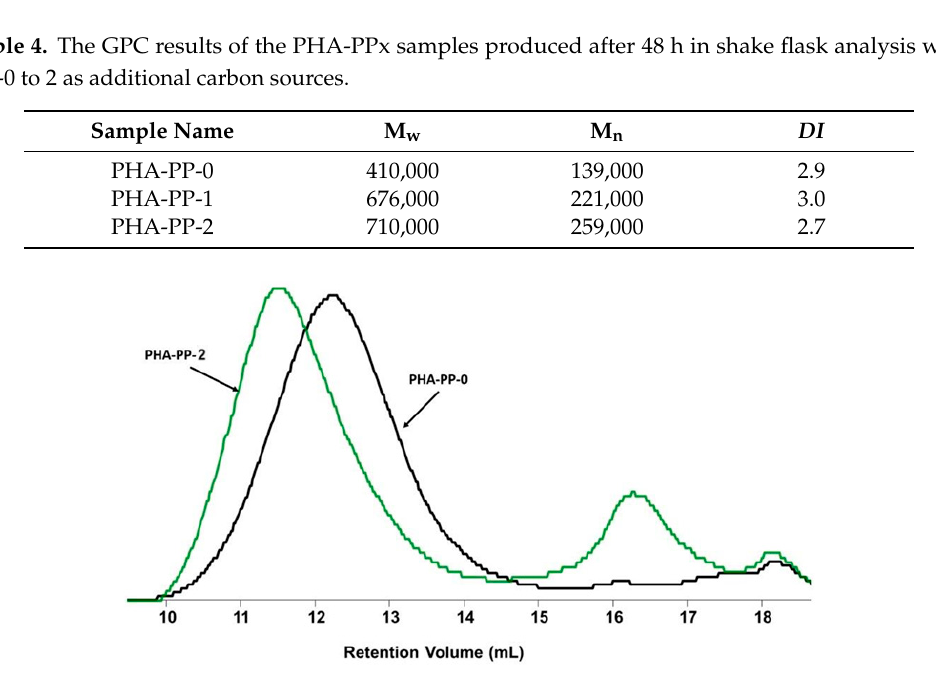
Figure 5. 1 H-NMR of PHAs produced by C. necator from TSB with the PP-2 sample as an additional carbon source.